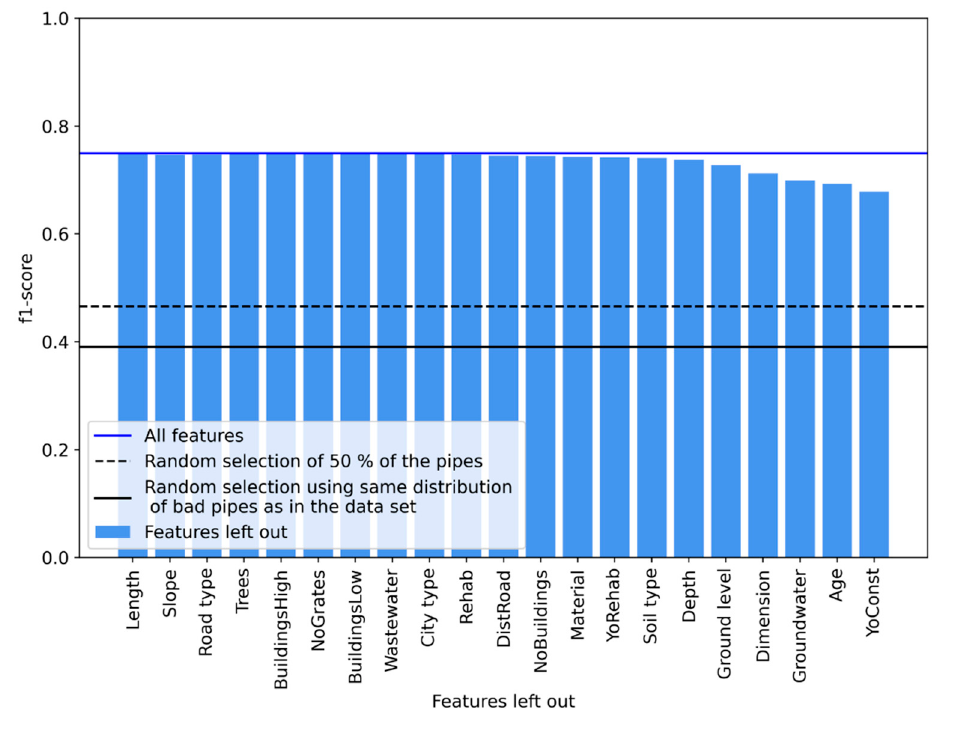
Figure 3. Backward feature step analysis for the new baseline where the geographical information has been removed. Each chart shows the performance when the least contributing feature remaining has been removed starting from the left and progressing to the right. The dashed black line shows the performance when randomly classifying 50% of the pipes as bad pipes and the solid black line shows the performance when randomly classifying a percentage of pipes, corresponding to the number of bad pipes in the dataset, as bad.